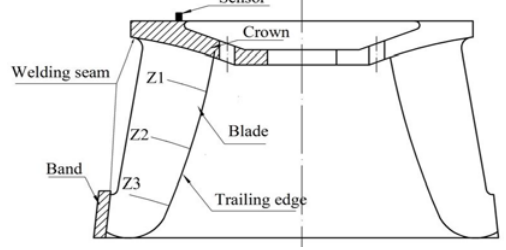
Fig. 2. A schematic of turbine runner